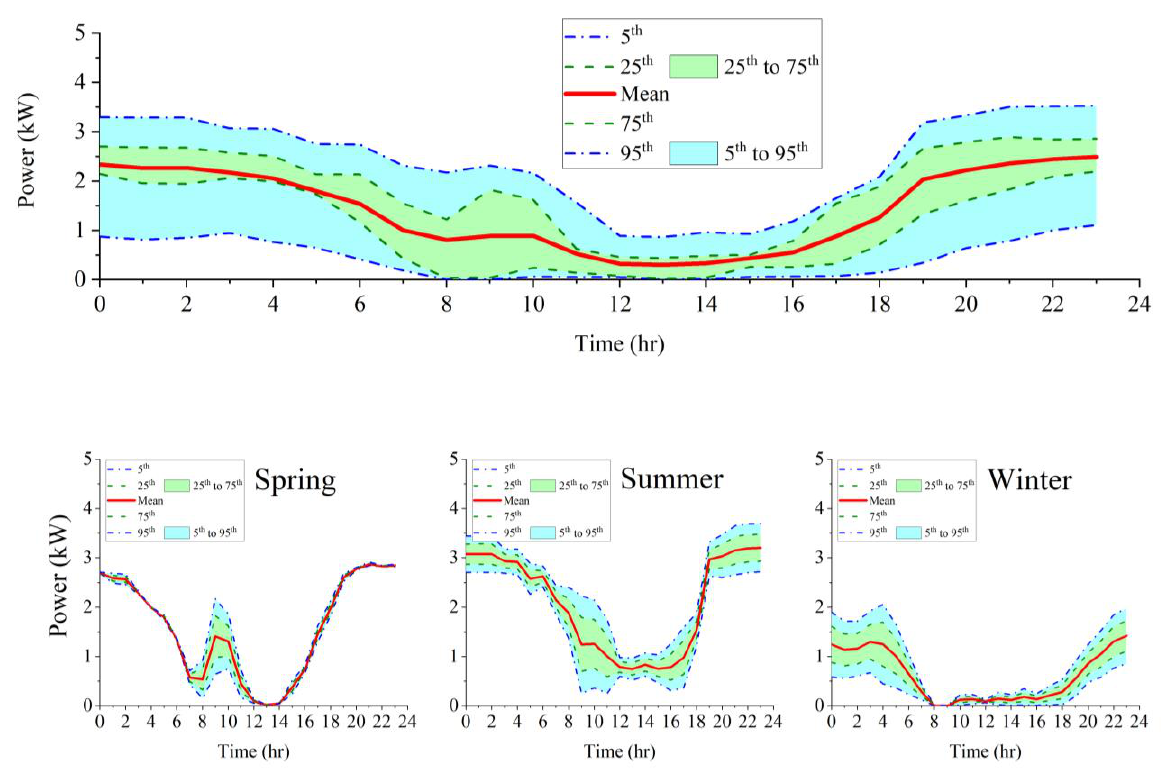
Figure 20. Average annual and seasonal chicken brooder daily load profiles (with percentile ranges).